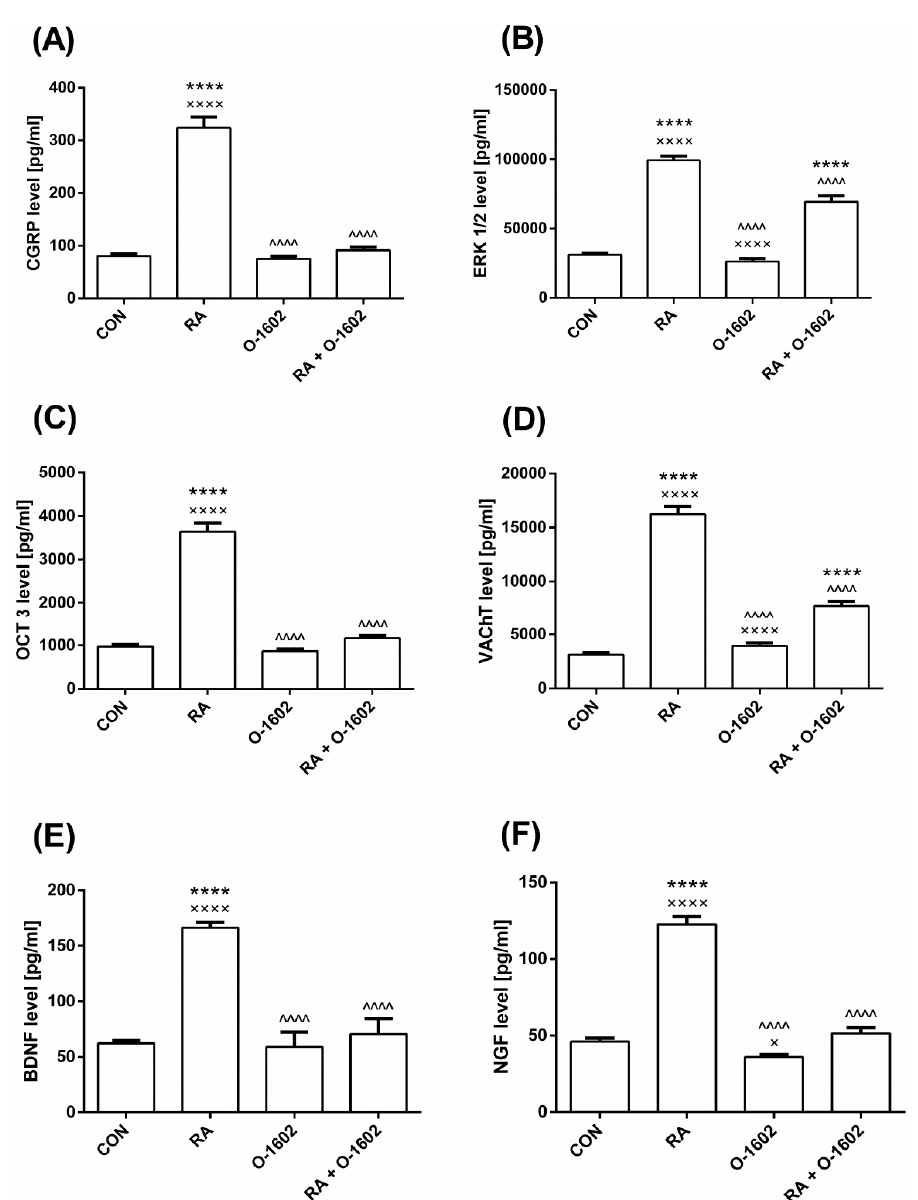
Figure 1. The influence of O-1602 administration in female rats with detrusor overactivity induced by RA on the level of (A) CGRP, (B) ERK1/2, (C) OCT 3 in the bladder urothelium, (D) VAChT in the bladder detrusor muscle, (E) BDNF, and (F) NGF in the urine. One-way ANOVA: F(3,56) = 119.1, p < 0.0001 for CGRP; F(3,56) = 136.8, p < 0.0001 for ERK1/2; F(3,56) = 143.5, p < 0.0001 for OTC 3 ; F(3,56) = 164.3, p < 0.0001 for VAChT; F(3,56) = 200.4, p < 0.0001 for BDNF; F(3,56) = 136.4, p < 0.0001 for NGF. All results are presented as the means ± SEM ( n = 15 rats per group). The obtained data were assessed by the one-way ANOVA followed by Tukey’s post hoc test. *, ^, or ×: p < 0.05; **, ^^, or ××: p < 0.01; ***, ^^^, or ×××: p < 0.001; ****, ^^^^, or ××××: p < 0.0001. *: Significantly different from the CON; ^: Significantly different from the RA group; ×: Significantly different from the RA + O-1602 group. Abbreviations: BDNF—brain-derived neurotrophic factor; CGRP—calcitonin gene related peptide; ERK1 / 2– extracellular signal-regulated kinase 1 / 2; NGF—nerve growth factor;